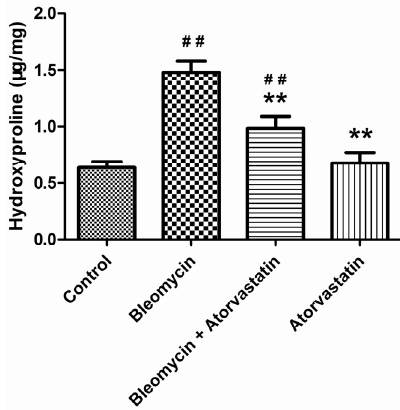
Figure 3. Effects of atorvastatin on the hydroxyproline content in the lungs of bleomycin-induced pulmonary fibrosis rats. Values are given as mean ± SD for groups of eight rats each. ## p < 0.01 vs. the control group; ** p < 0.01 vs. the bleomycin group.